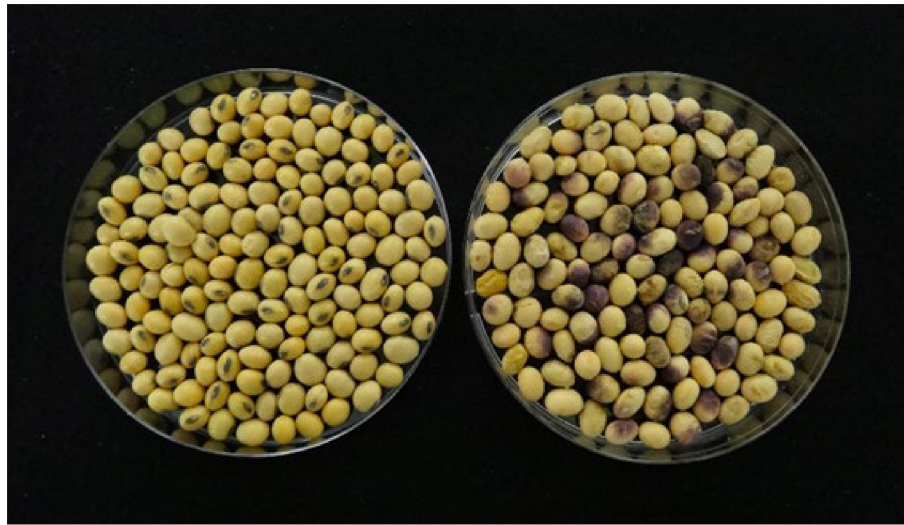
Fig 1. Soybean healthy seeds vs. purple seed stain. Healthy seeds without discoloration (left), while seeds with purple seed stain disease (right) usually show a pink to light or dark purple